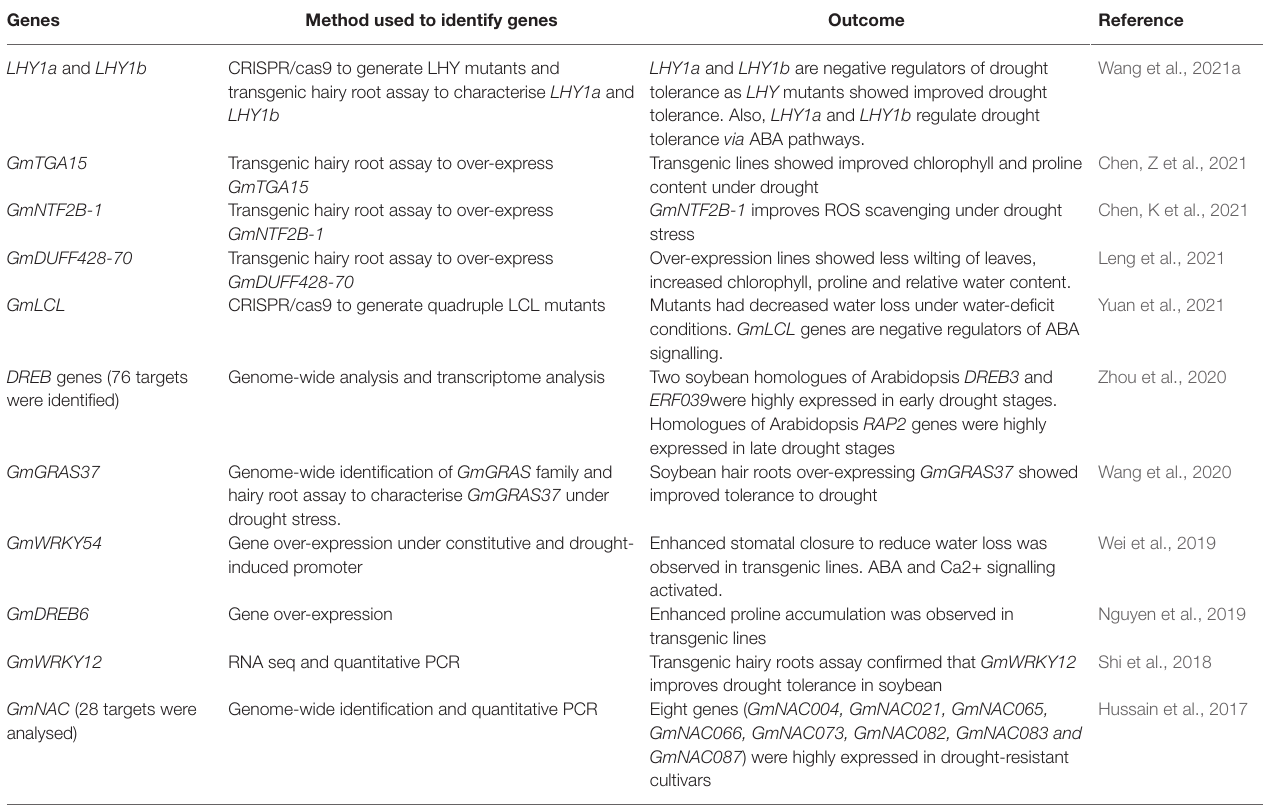
TABLE 2 | A summary of recently characterised gene targets for engineering drought tolerance in soybean. Genes Method used to identify